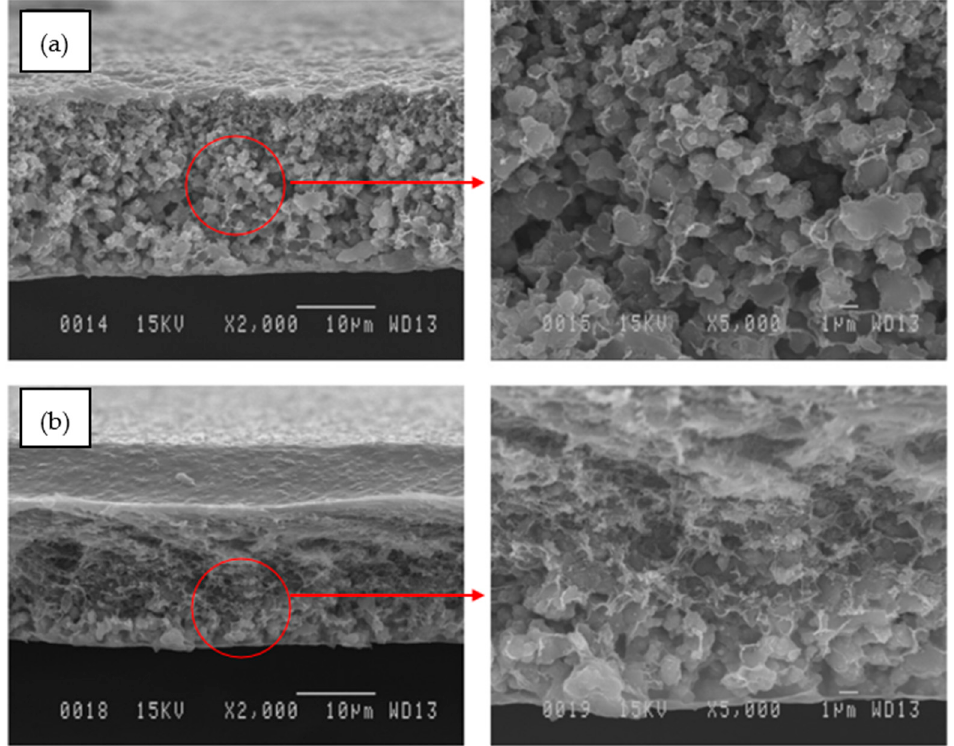
Figure 5. Cross-sectional SEM images of ( a ) UiO-66/6FDA-ODA and ( b ) NH 2 -UiO-66/6FDA-ODA [83].